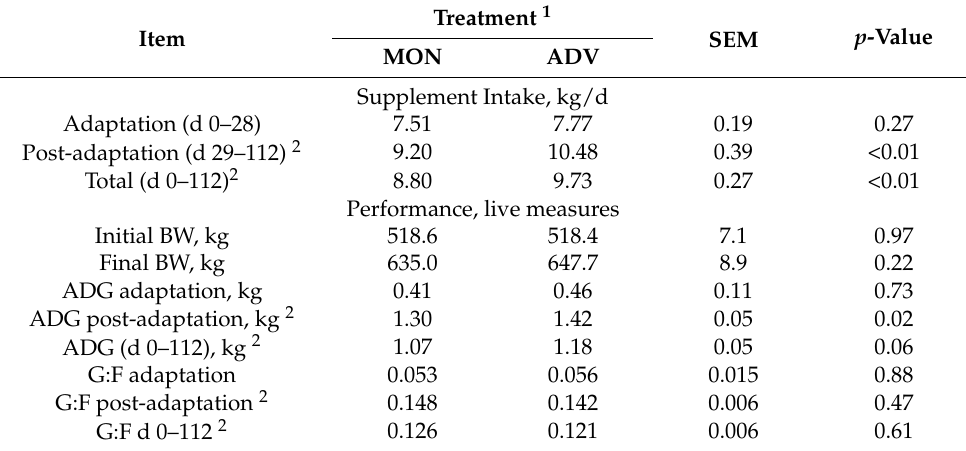
Table 4. Supplement intake and animal performance of Nellore bulls finished on pasture with high concentrate supplementation, with monensin (MON) or a blend of live yeast and organic minerals (ADV). Treatment 1 Item SEM p -Value MON